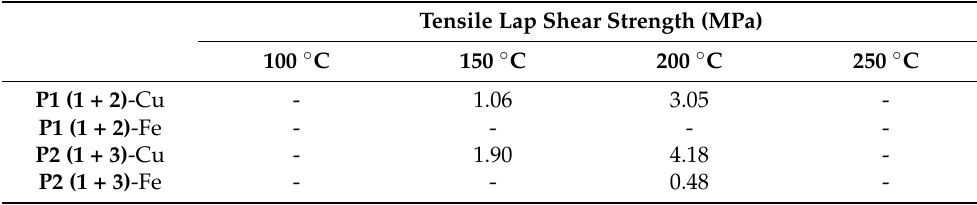
Figure 3. Adhesive properties of the in situ polymerized P1 (1 + 2) and P2 (1 + 3) on copper (Cu) and iron (Fe) plates under different conditions (at 150 ◦ C or 200 ◦ C for one hour). Table 1. Adhesion conditions and tensile lap- hear strengths (MPa) of the in situ polymerized P1 and P2 according to JIS K